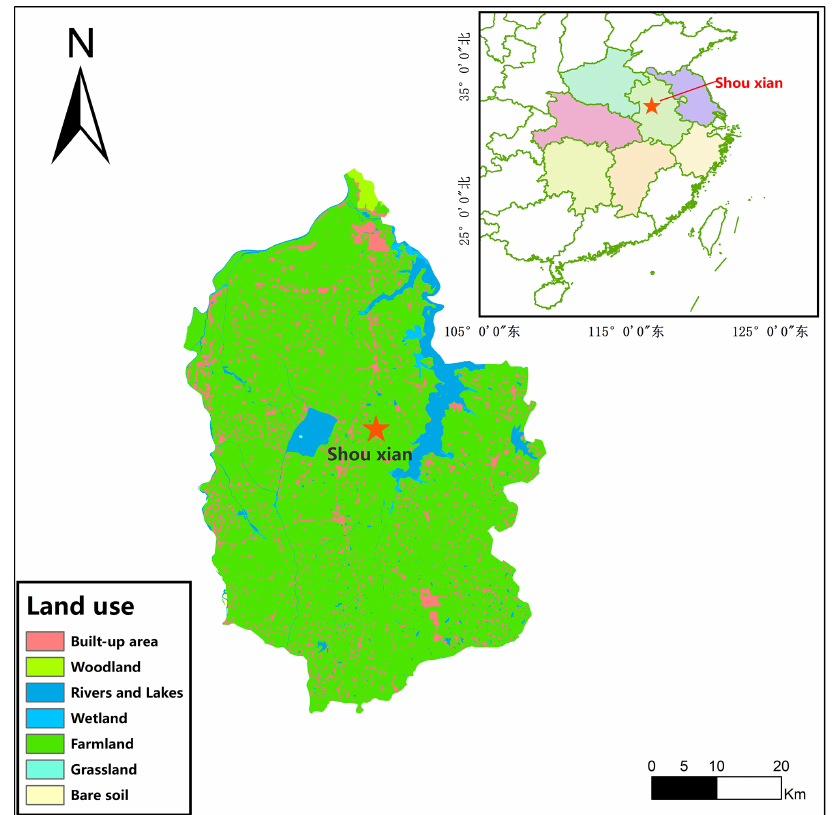
Figure 1. Geographical location and land cover map of Shouxian County.